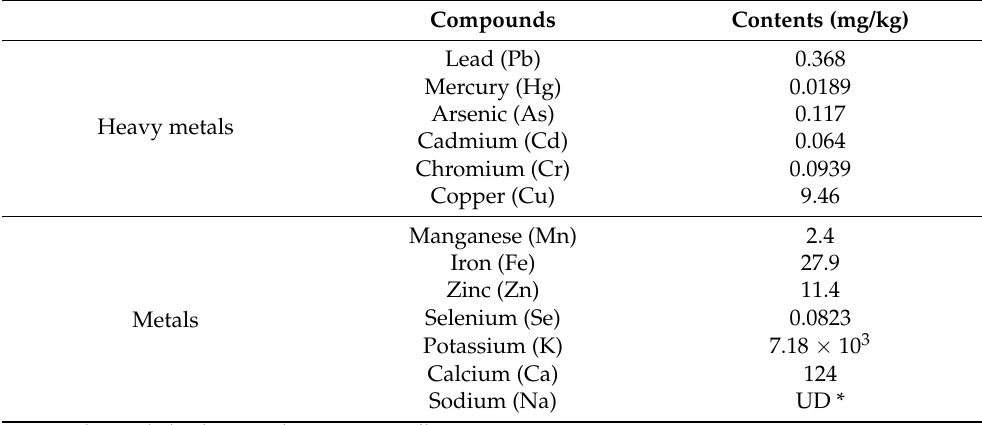
Table 2. The heavy metals and metal composition of